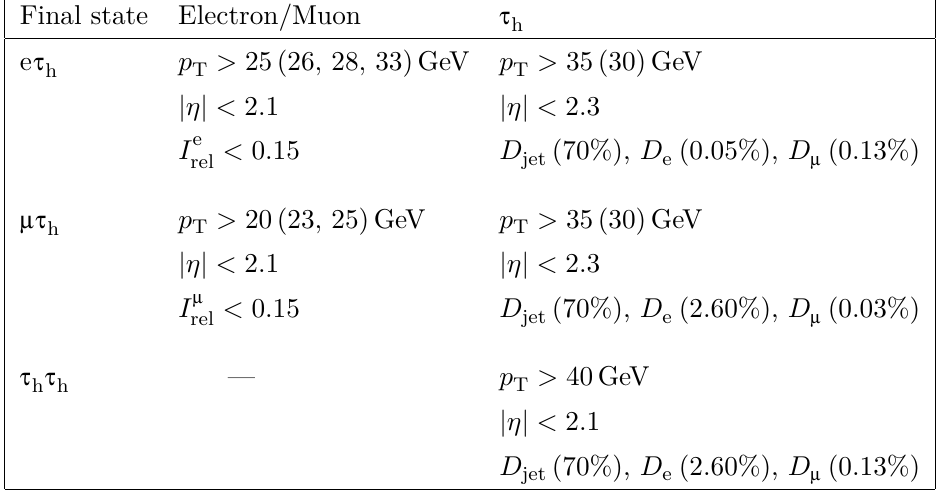
Table 2 . Offline requirements applied to electrons, muons, and t of the t pair. The p values in parentheses correspond to events selected by a single-electron or T single-muon trigger. These requirements depend on the year of data-taking. For D and for D the misidentification rates for the chosen working points are given in parentheses. A e( m ) detailed discussion is given in the